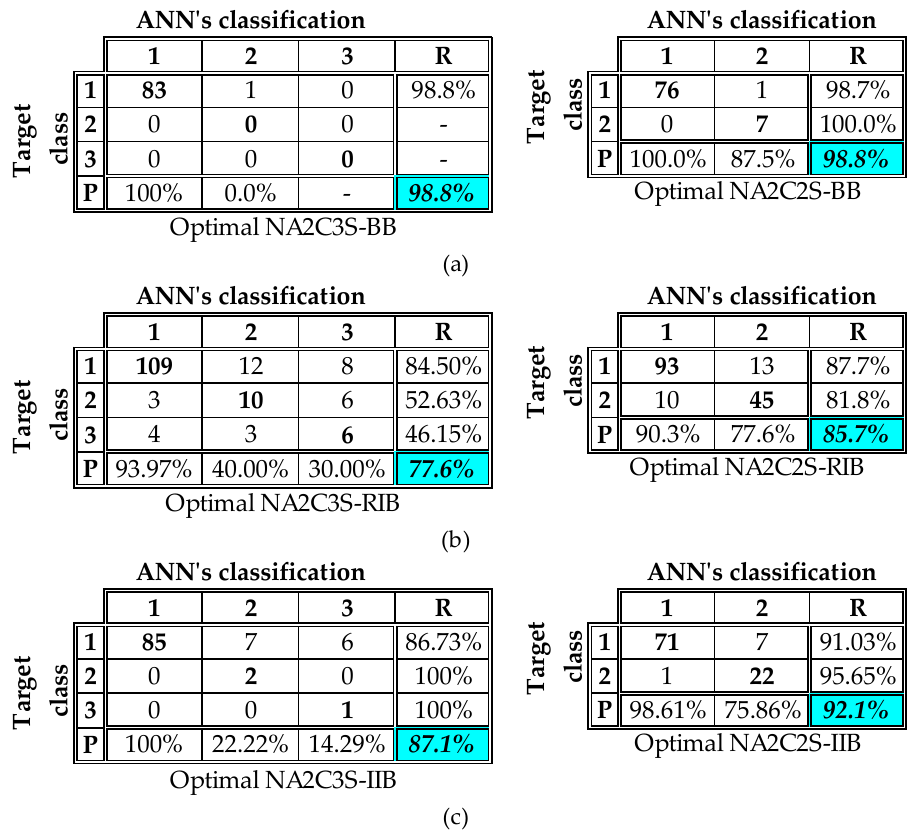
Figure 10. CMs according to the testing subsets extracted by the optimally configured NA2C3S and NA2C2S networks: ( a ) BB; ( b ) RIB; ( c ) IIB.